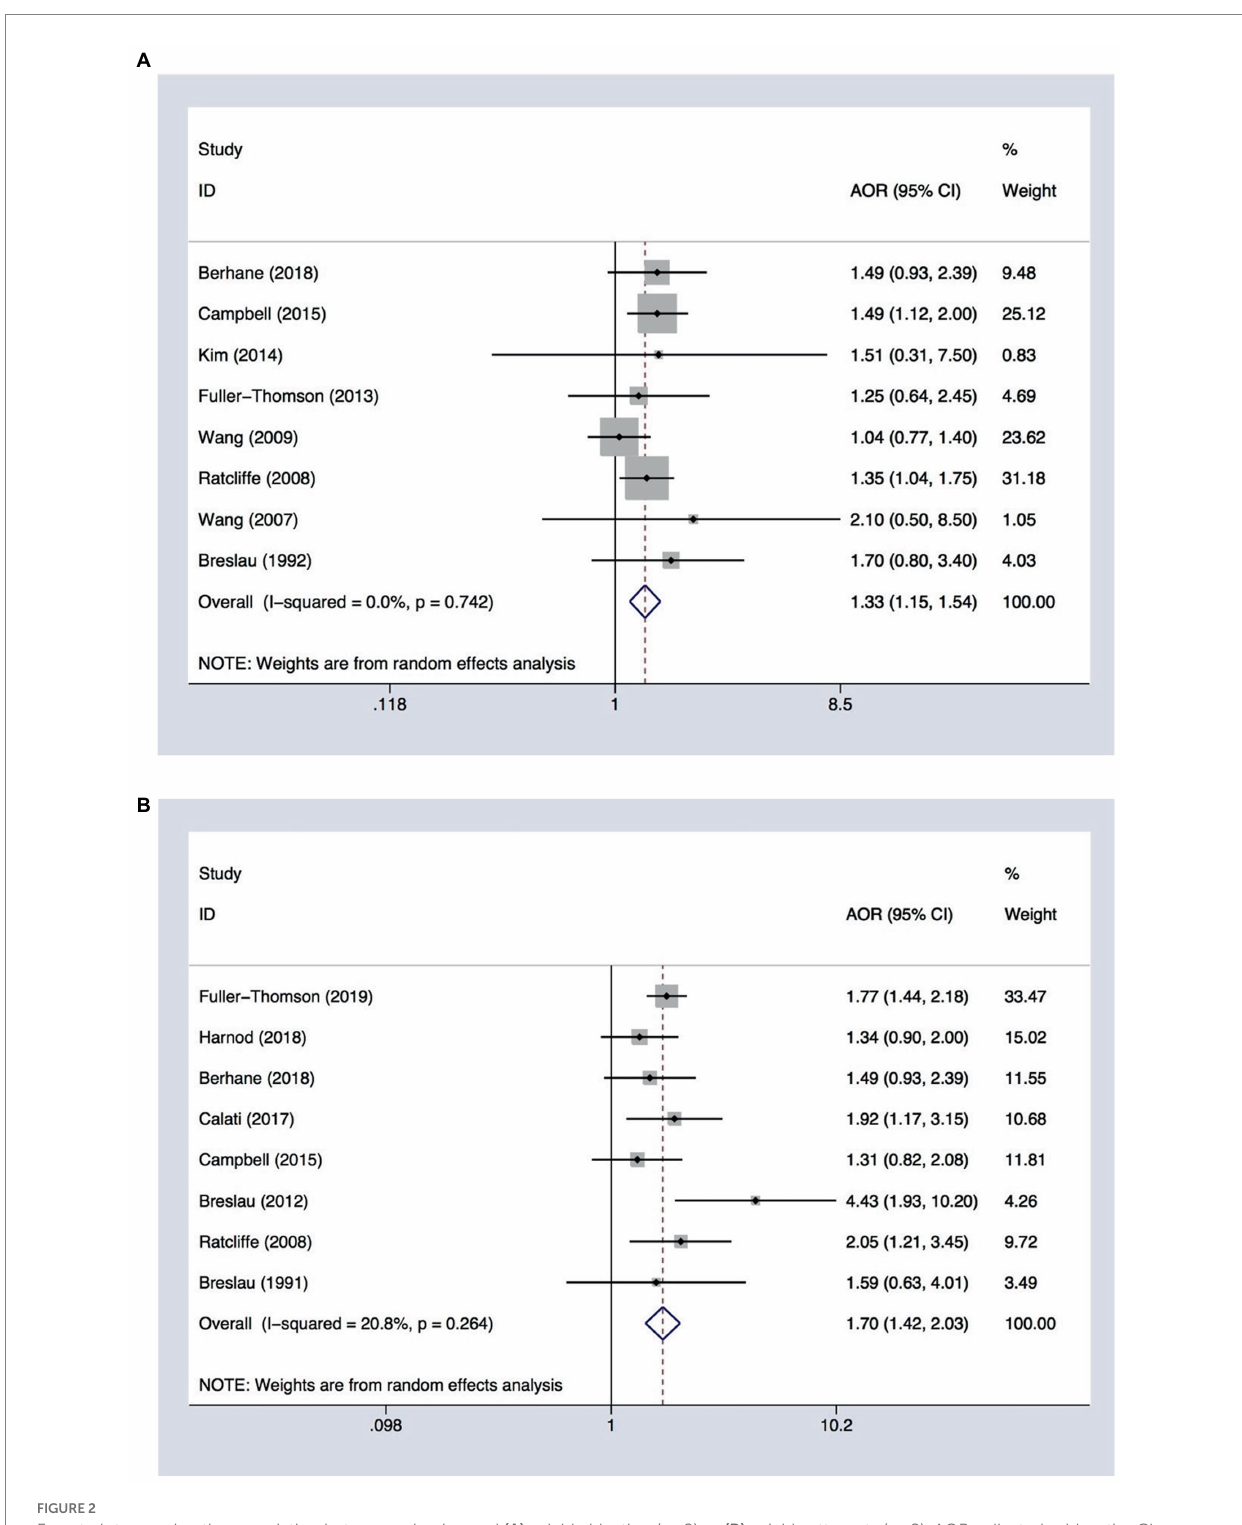
FIGURE 2 Forest plot assessing the association between migraine and (A) suicide ideation ( n = 8) or (B) suicide attempts ( n = 8). AOR, adjusted odds ratio; CI, confidence